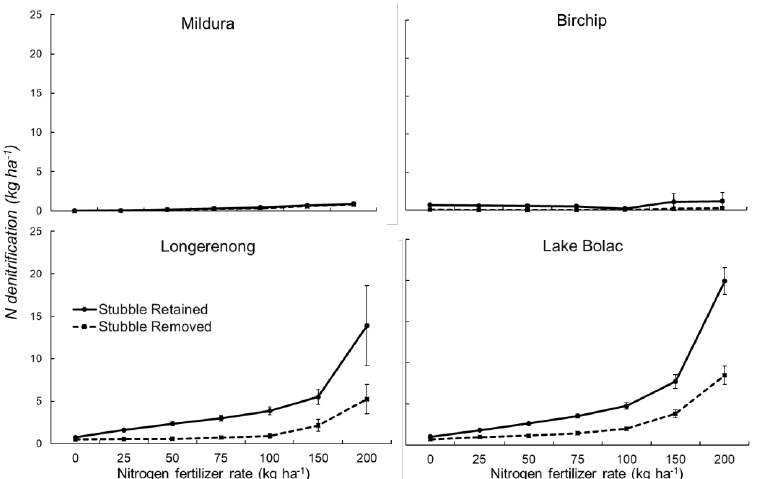
Figure 6. Effects of N application rate and stubble retention (retained vs. removed) on mean (1990–2016) annual denitrification at four field sites. Error bars represent ± standard error of the mean over the years of the